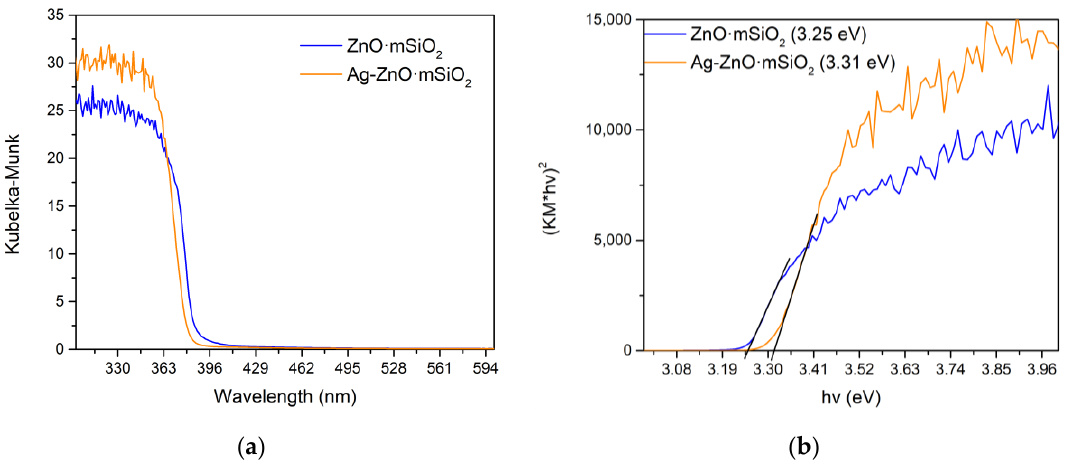
Figure 4. ( a ) UV-Vis absorption spectra and ( b ) Tauc plots with estimated band gap values of Ag-ZnO· m SiO 2 and ZnO· m SiO 2 substrate.